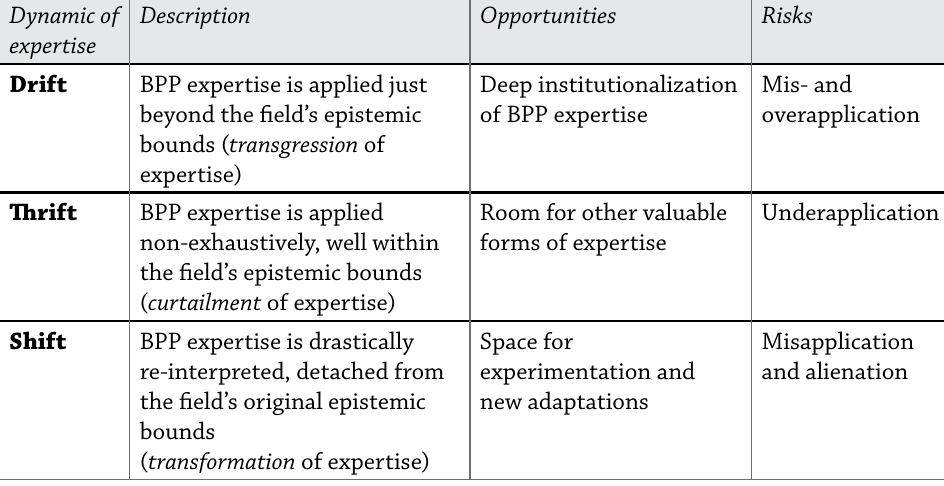
Table 1. Dynamics of BPP